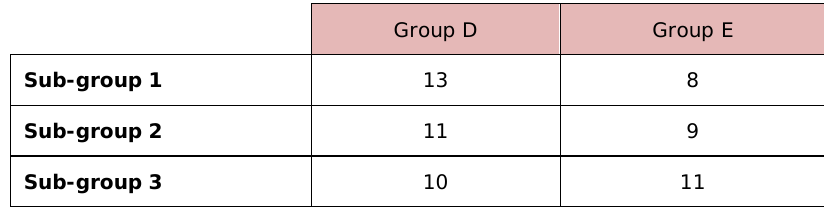
Table 3. “Working groups in each practical sub-group set up in general groups D and E”. Source: